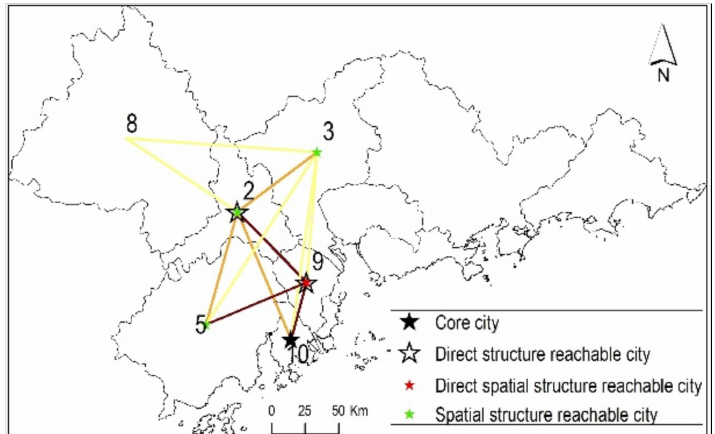
Figure 5. The Spatial structure reachable cities of core city